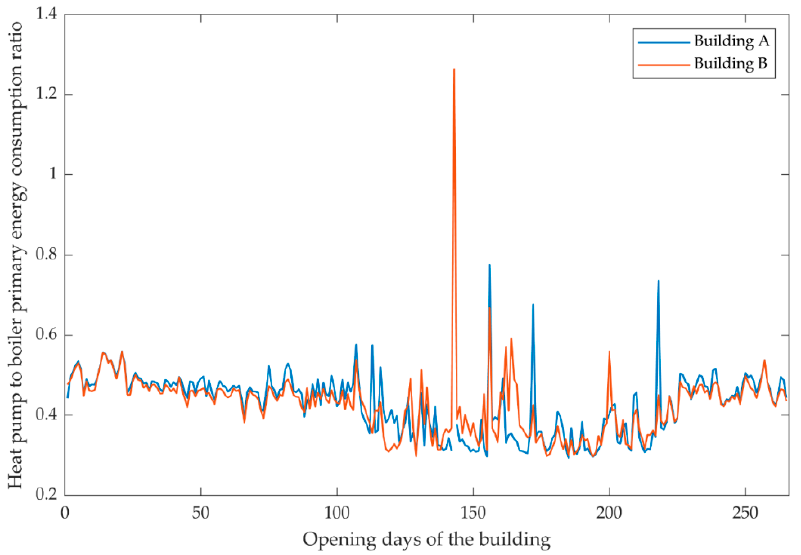
Figure 10. Comparison between the primary energy consumption obtained with the HP as heating system with respect to the boiler.